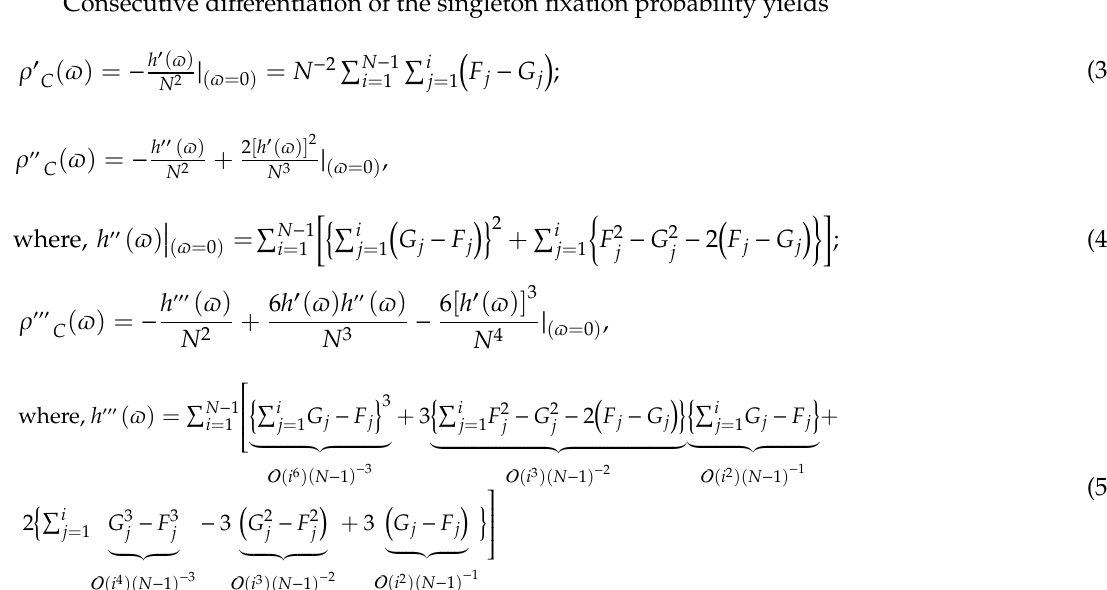
E ffi cient calculation of the requisite third derivative ρ of magnitude in the corresponding summations. Note that the summation of index powers can be calculated with the use of descending factorials ([24], Equation (2.50)). For instance, after some algebra, (cid:80) N −